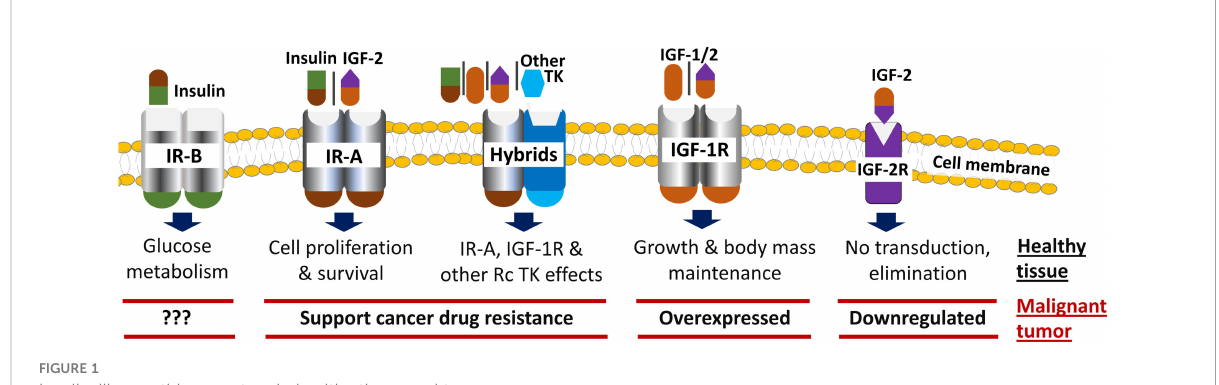
FIGURE 1 Insulin-like peptide receptors in healthy tissue and